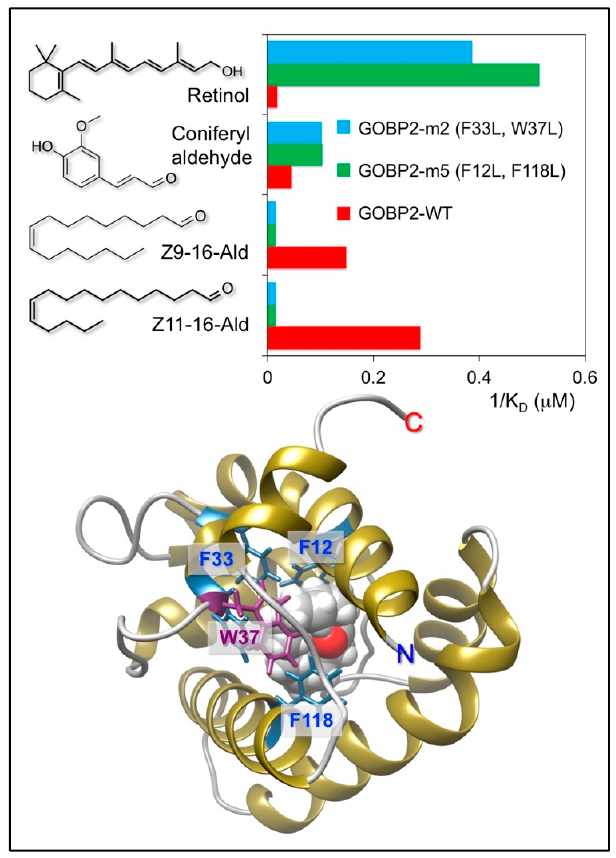
Figure 4. The GOBP2 of the moth Plutella xylostella binds with good affinity linear aldehydes, components of the sex pheromone of this species. By replacing two aromatic residues inside the binding pocket with leucine, the specificity of the protein can be switched from linear aldehydes to branched terpenoid compounds.